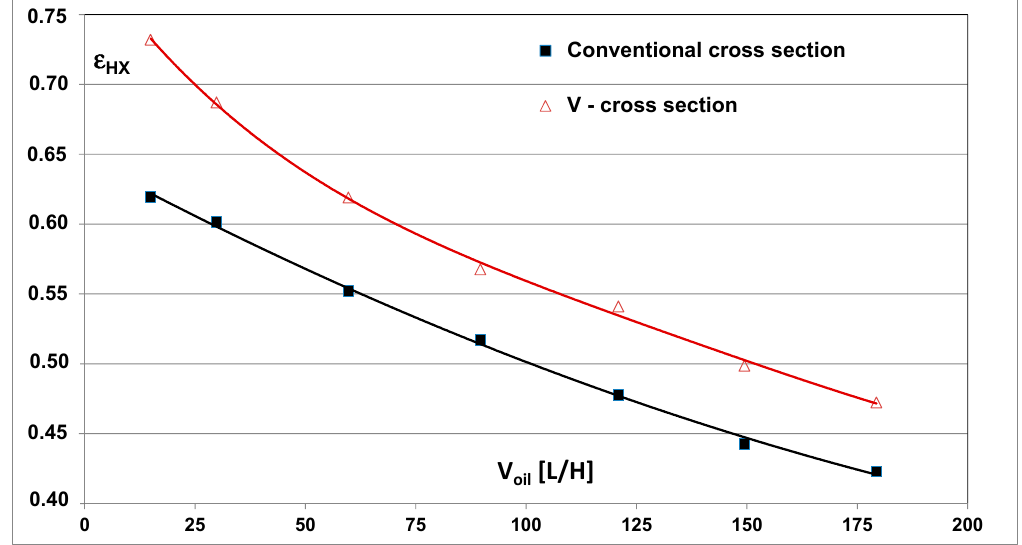
Figure 24. Efficiency comparison between the two types of cross sections. The V-type cross section could show an average efficiency benefit of 16% throughout the oil cooling flow range between 20 and 180 L/h.